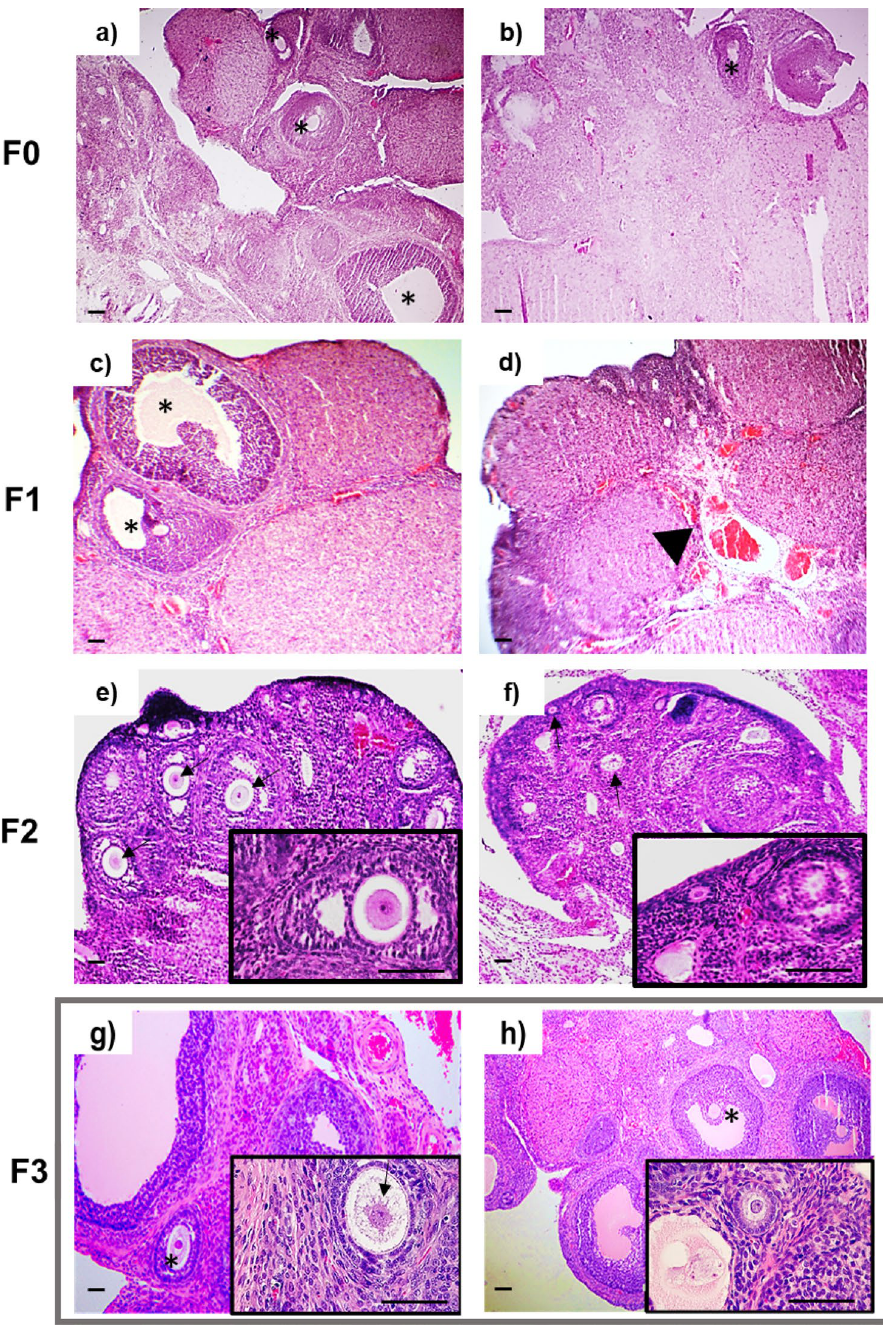
Figure 6. Hematoxylin and eosin stained ovarian sections (n = 32) of females exposed directly to arsenic ( b ) proliferating follicles are observed (*), while in their offspring, F1 ( d ), it’s shown marked vascular congestion (arrowhead), the posterior offspring ( f , h ) present proliferating follicles with visible ovules (arrows) of normal characteristics. The ovaries of the females in the control group ( a ) and their F1–F3 offspring ( c , e , g ) presented normal morphological characteristics. Bars = 100